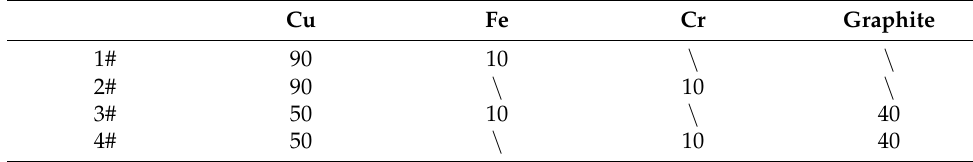
Table 1. Chemical compositions of Cu–BCs (vol.